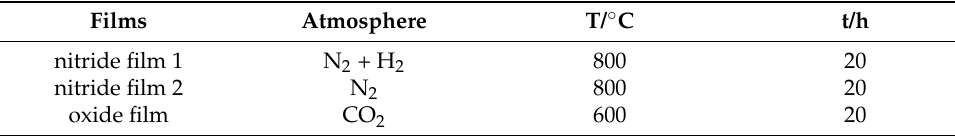
Table 2. Preparation conditions of three different films on zirconium hydride.